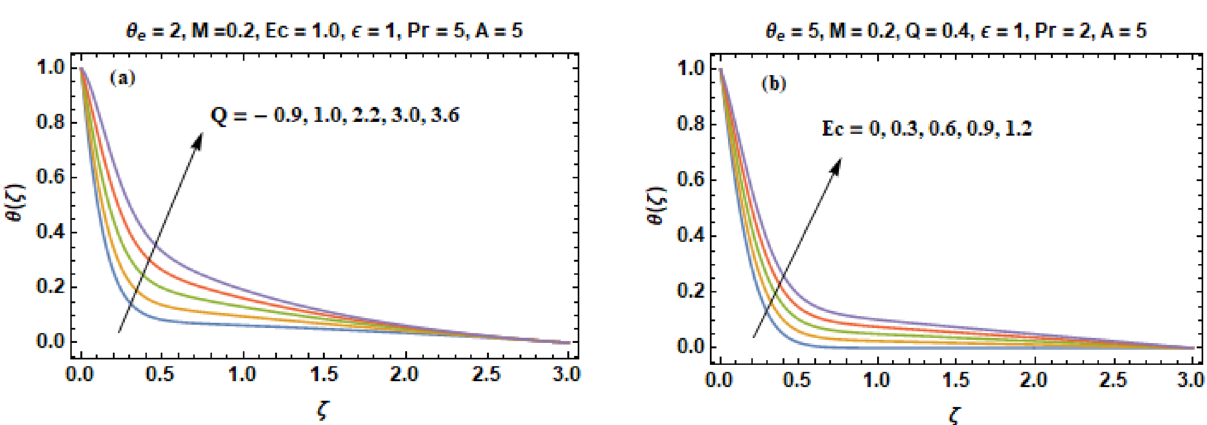
Figure7. ( a–b ) Temperature curves (θ) versus heat generation/absorption Q and Eckert number Ec